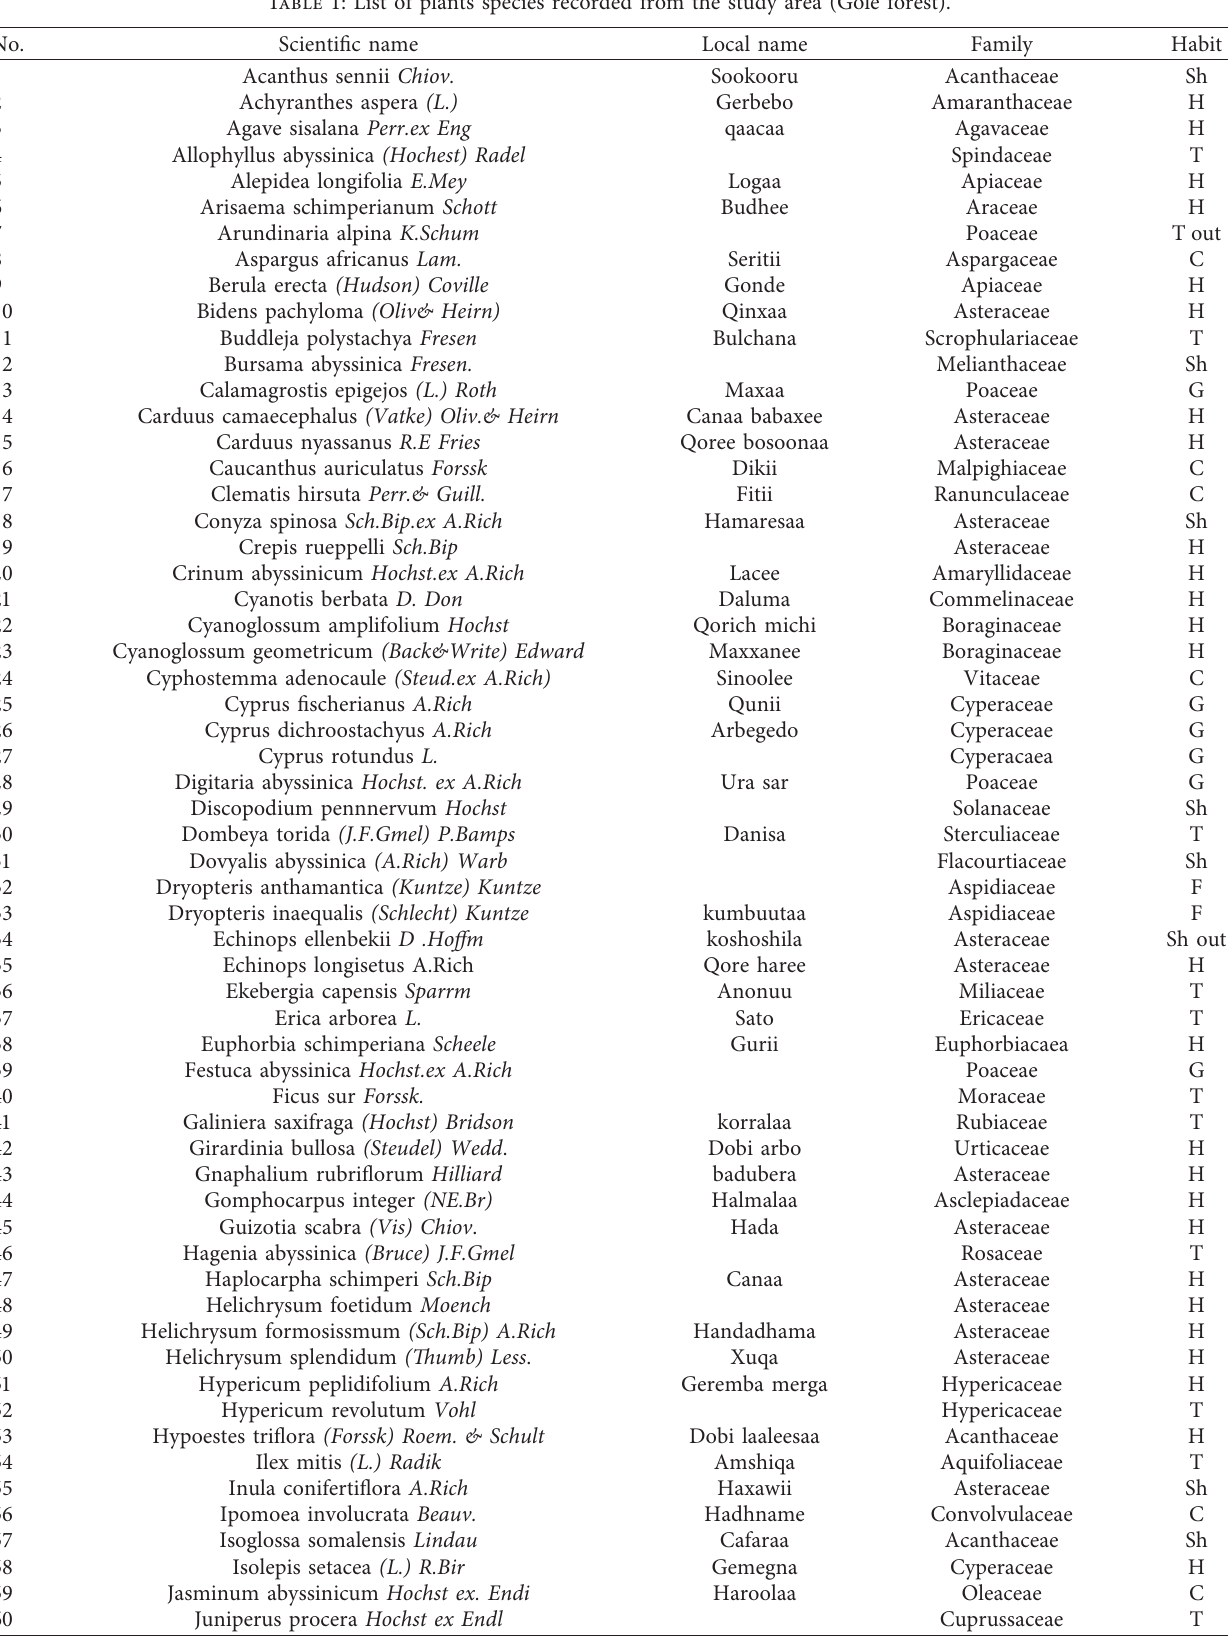
Table 1: List of plants species recorded from the study area (Gole